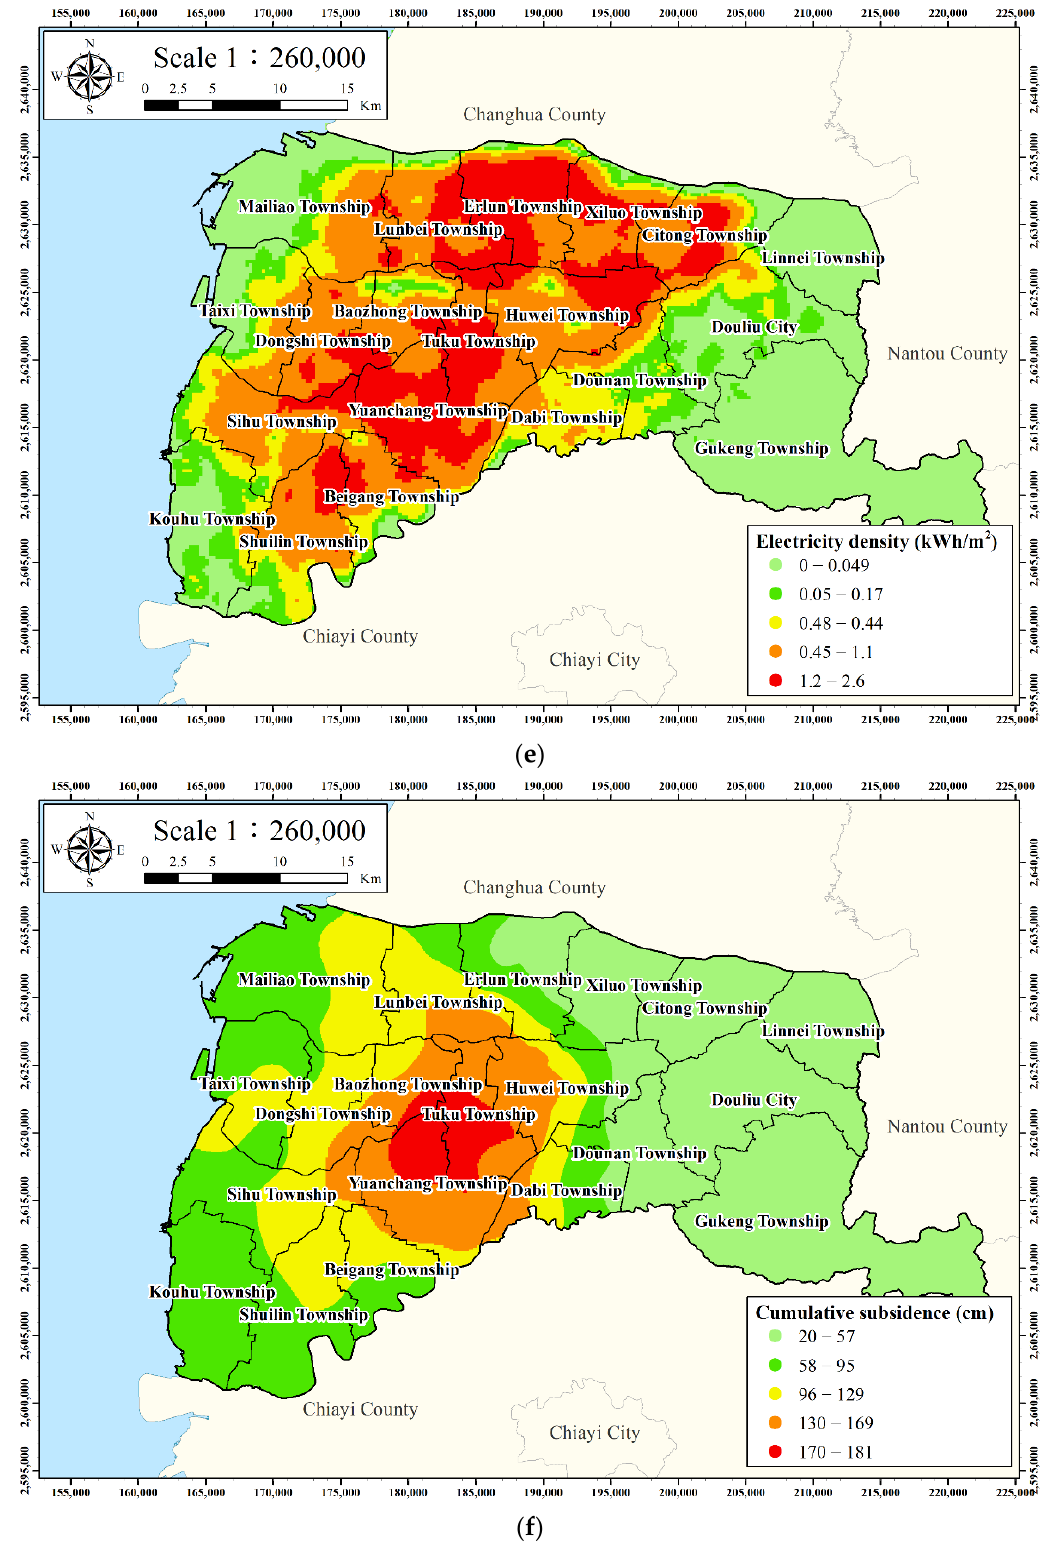
Figure 2. Thematic maps of Yunlin County, Taiwan, and relevant factors: ( a ) percentage of fine- grained soil; ( b ) length of average maximum drainage path; ( c ) percentage of agricultural land use; ( d ) distribution of the managed wells; ( e ) electricity consumption of wells; and ( f ) accumulated subsidence depth from 1992 to 2020.